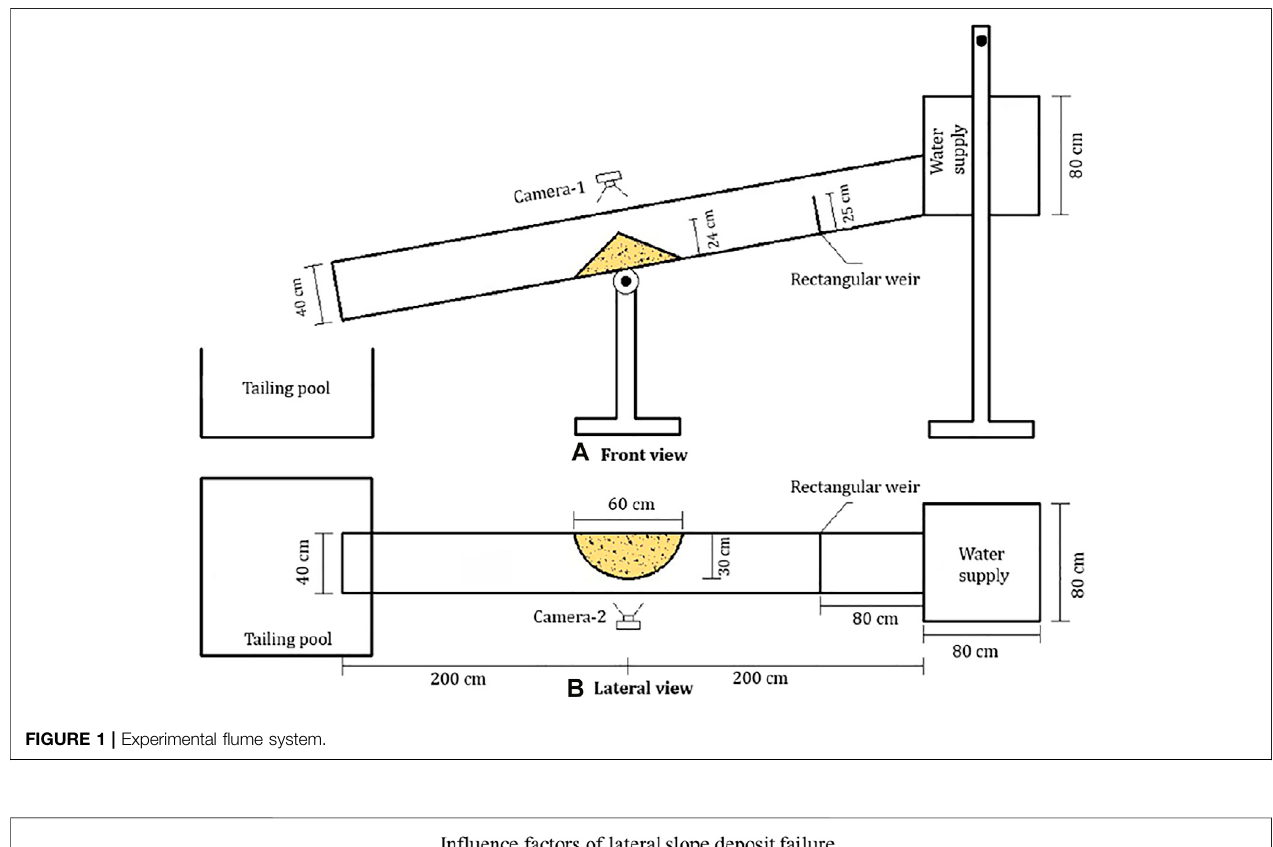
FIGURE 1 | Experimental fl ume system.